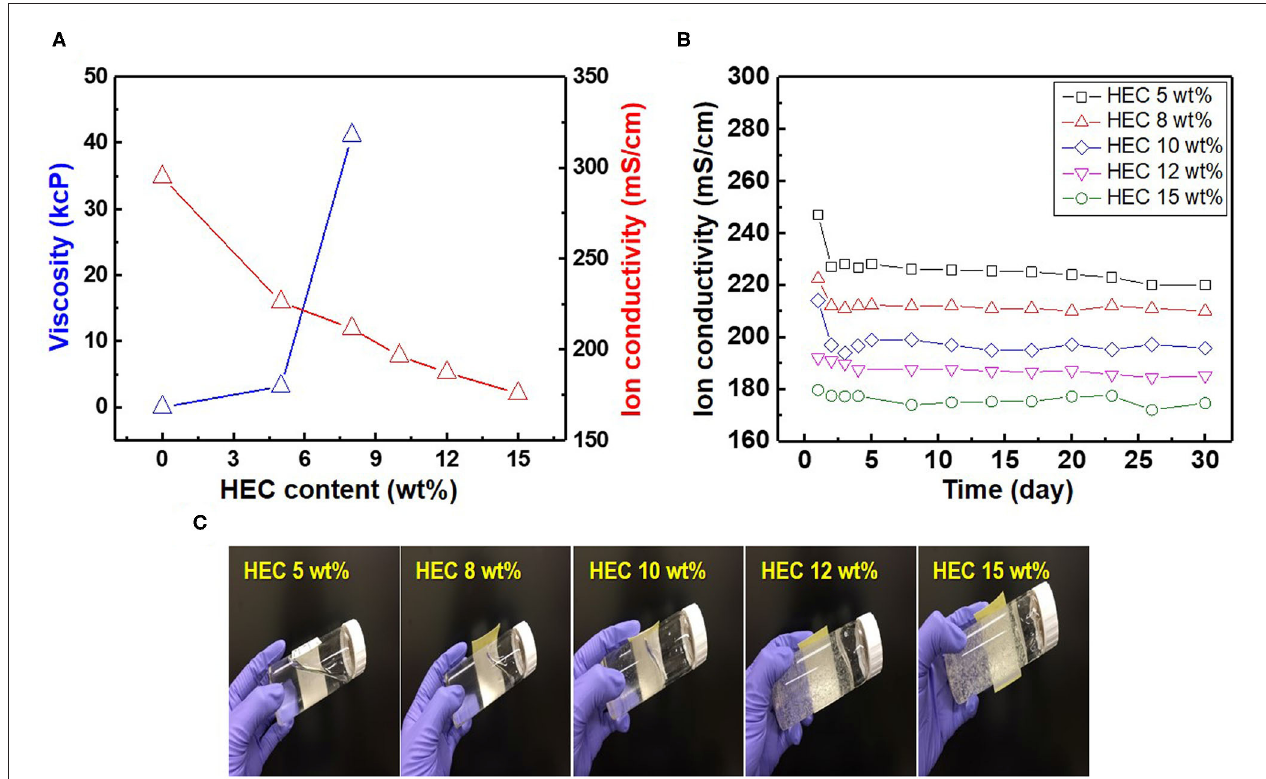
FIGURE 2 | Relationship between (A) hydroxyethyl cellulose (HEC; wt.%), viscosity, and ion conductivity, (B) time-dependent ion conductivity, and (C) optical images of gel-type electrolyte with different HEC